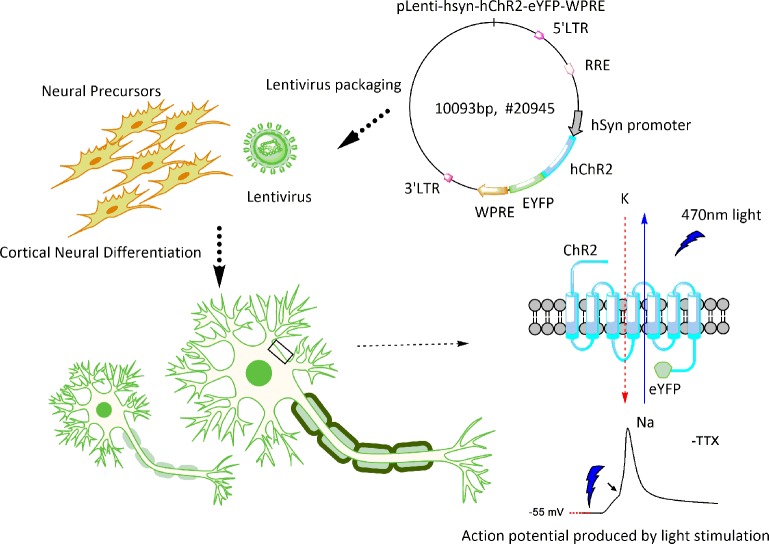
General schema of hES cell differentiation.Optogenetically engineered human neural precursors were differentiated into neurons with forebrain fate preference. The functionality of derived neurons was measured by their light-responsive action potentials and synaptic activity in vitro and the induction of the immediate early gene c-FOS in host neurons in vivo.